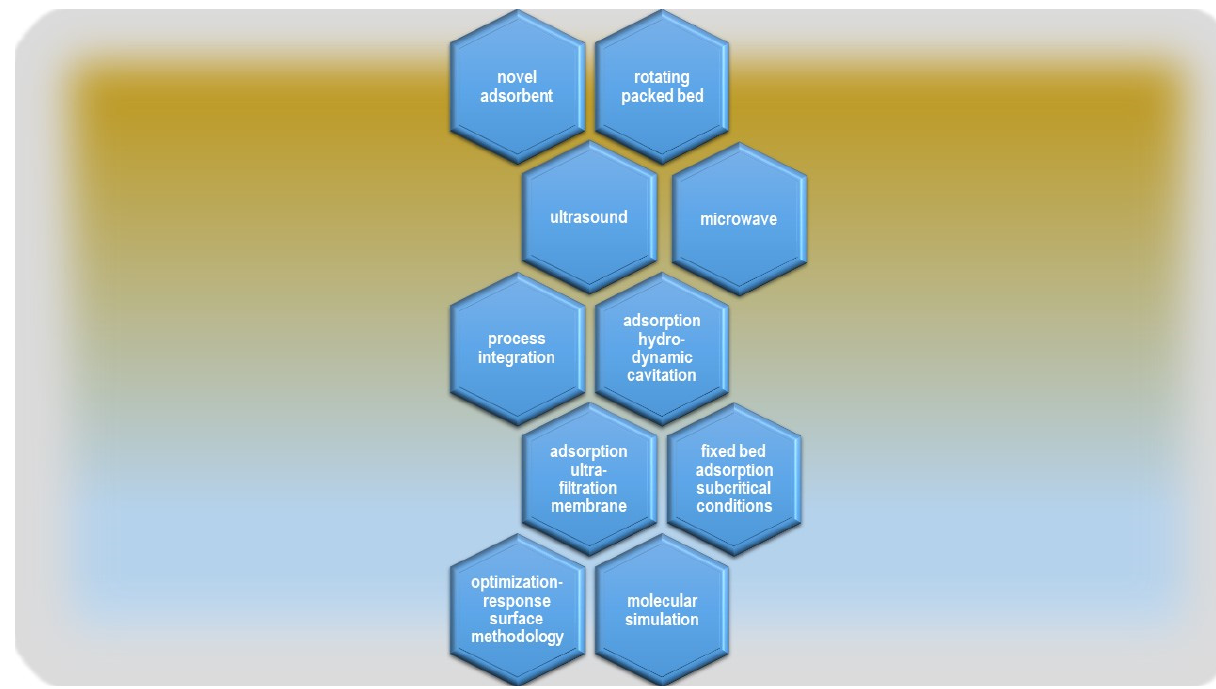
Figure 1. Intensification techniques applied to decolorization of dyes; removal of aromatic hydrocarbons from wastewaters; and recovery of proteins, heavy metals and rare earth elements from aqueous media.